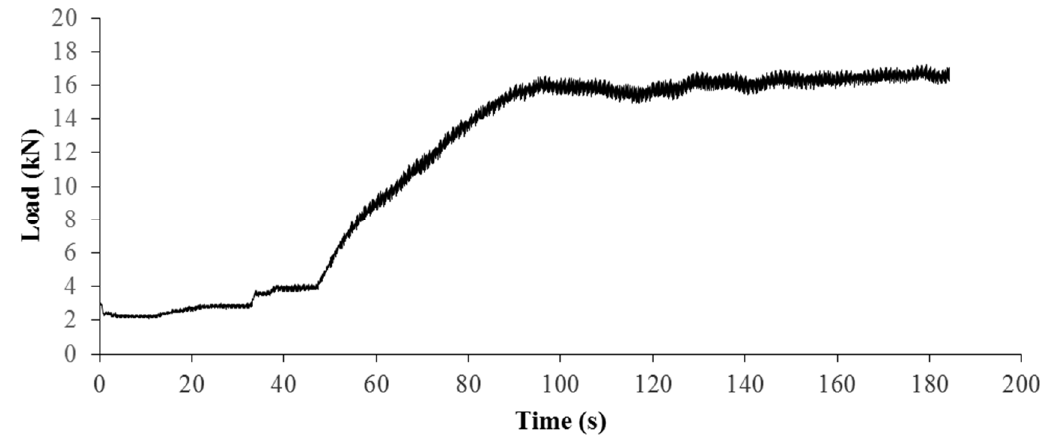
Figure 5. Uniaxial load-time curve of clay specimen.